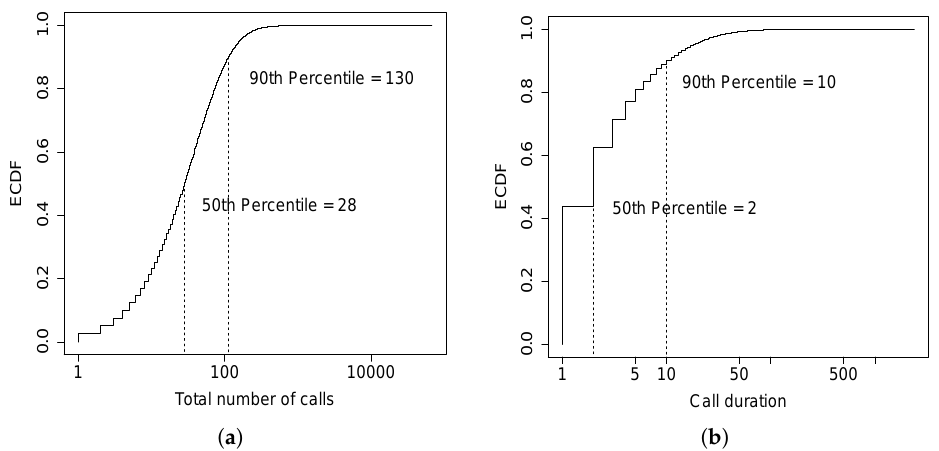
Figure 22. ECDF of the # of calls and call duration over 10 days. ( a ) # of calls; ( b ) Call duration in minutes.